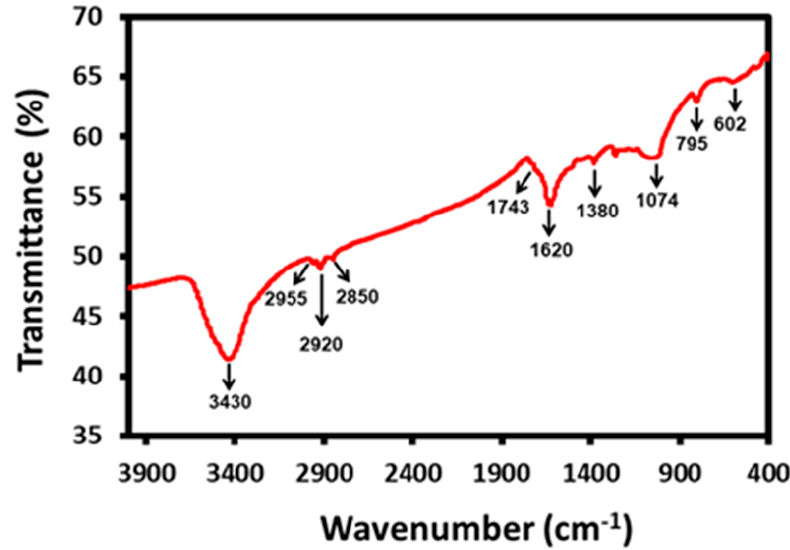
Figure 4. FTIR spectrum of the prepared AgNPs-G.